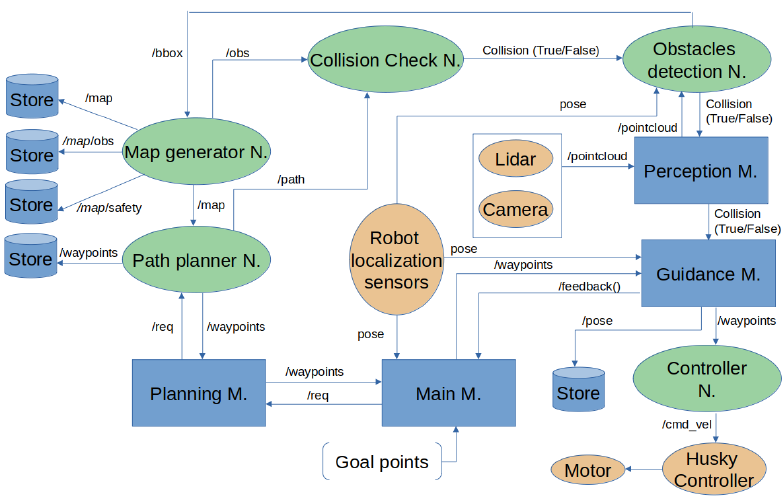
Figure 4. The ROS nodes scheme shows the system architecture in the first